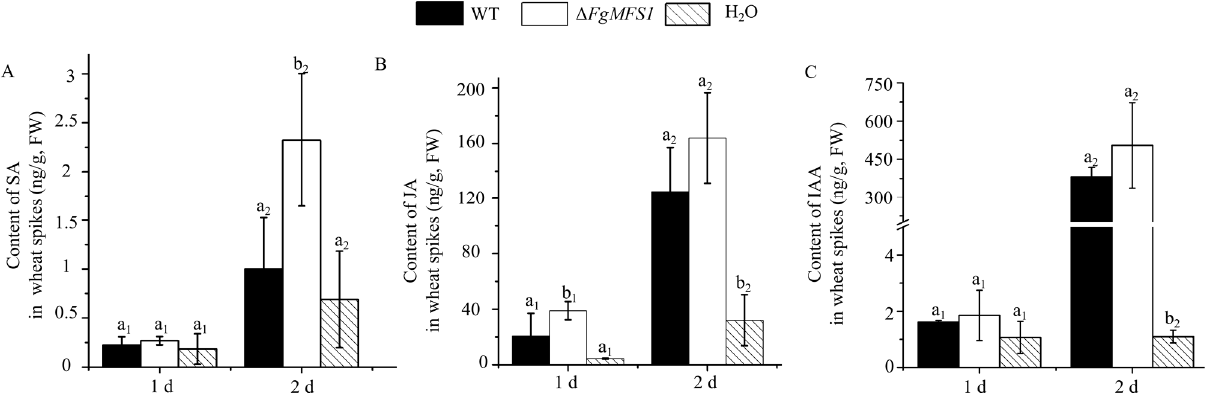
Figure 7. Contents of SA ( A ), jasmonic acid (JA; B ), and indole acetic acid (IAA; C ) in spikes, respectively, inoculated with water (CK), WT, and Δ FgMFS1 on the 1 st and 2 nd dpi. Values are the mean ± standard deviation. “a 1 , b 1 ” and “a 2 , b 2 ” are used to show the significance at P < 0.05 within treatment, since there are more than one treatments in the same chart. FW, fresh weight.